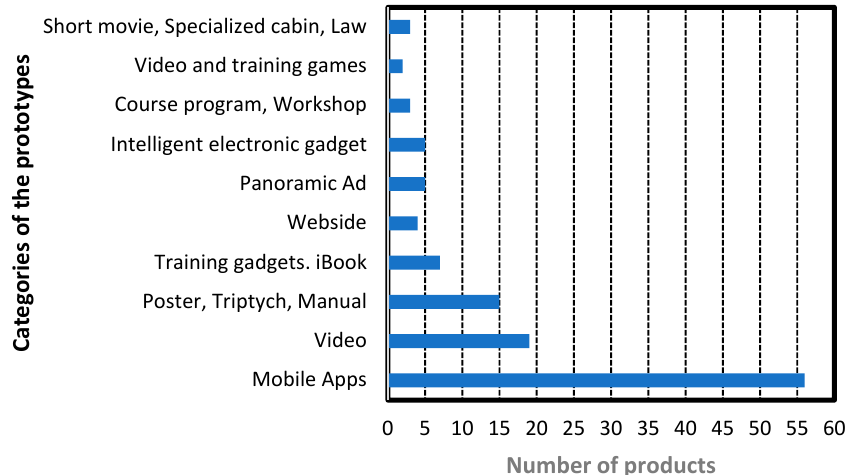
Figure 13. Typical categories of the product prototype generated during the EFR i-Week from 2015 to 2019.